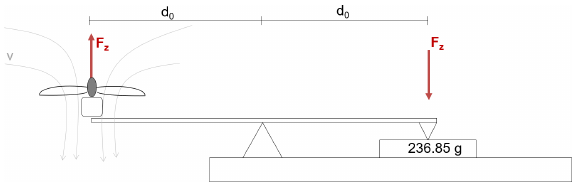
Figure 2. Schematic of the motor test stand. The rotor is producing thrust in the free stream and the counteracting force of the equal length lever arm is measured with a scale on a table.